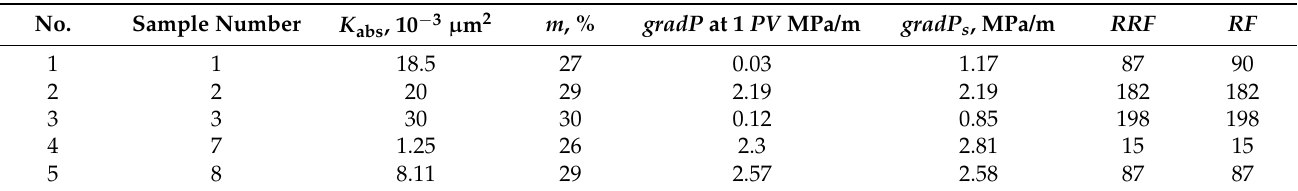
Table 7. Results of the core flooding tests at a single core model of the proposed polymer composition without a gel-time modifier.